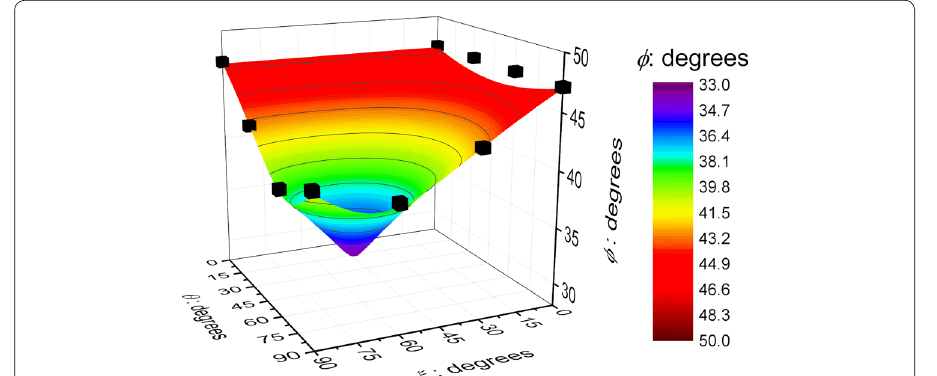
Fig. 21 Predicted anisotropic strength surface ( b